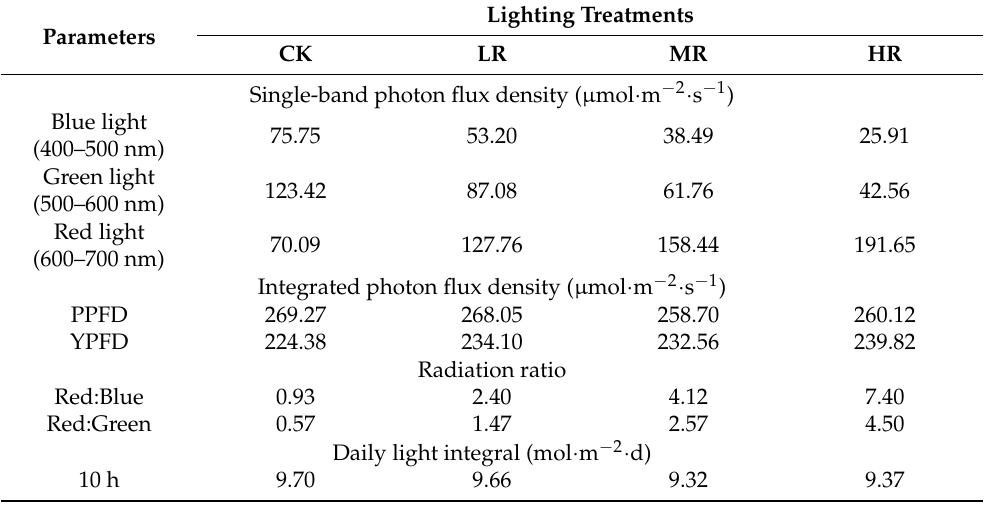
Table 1. Lighting parameters of